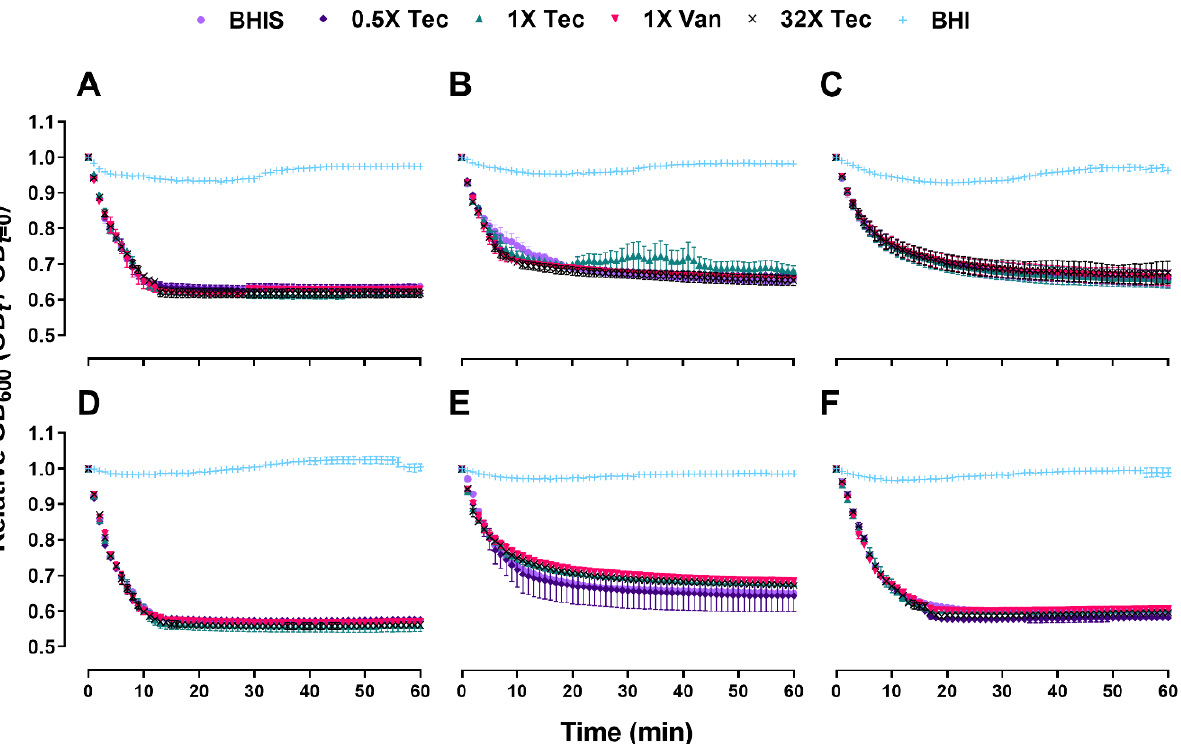
Figure 2. Teicoplanin and vancomycin do not inhibit spore germination. C. difficile spores were exposed to different concentration of antibiotics in relation to their respective MICs, and germination was followed by measuring loss of OD 600 for 1 h at 1 min time interval. The growth control contained no antibiotic, and as a comparator, vancomycin was included. Data points represent the mean of the relative OD 600 at the indicated time points normalized to t = 0 (control). All the experiments were performed in triplicates and error bars represent the standard errors. The results include the strains: ( A ) F101; ( B ) F102; ( C ) A125; ( D ) A126; ( E ) R20291; ( F ) H203. Circle (●), diamond ( ), triangle ( ▲ ), inverted tringle ( ▼ ), cross ( × ), and plus (+) denote the exposure to BHIS, 0.5 × MIC teicoplanin, 1 × MIC teicoplanin, 1 × MIC vancomycin, 32 × MIC teicoplanin, and BHI, respectively. Abbreviations: Tec = teicoplanin, Van = vancomycin, BHI = Brain heart infusion broth without 0.1% sodium taurocholate, BHIS = Brain heart infusion broth supplemented with 0.1% sodium taurocholate.